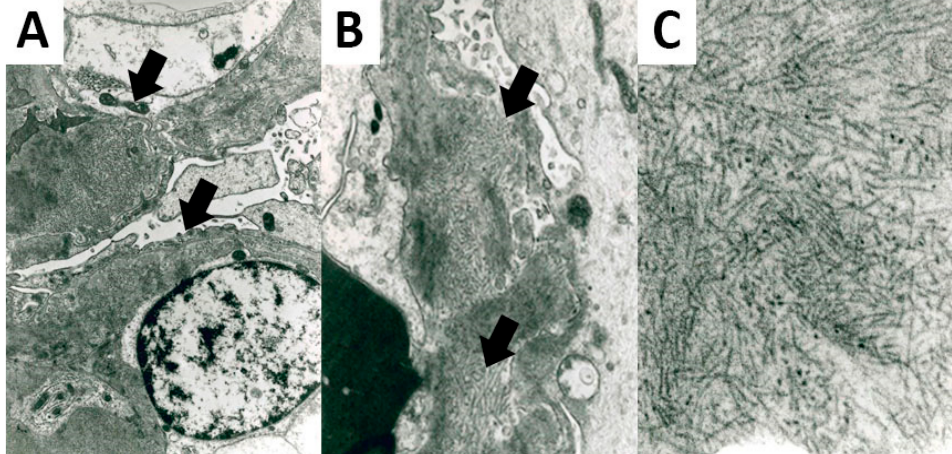
Figure 2. Ultrastructural features of FGN. Fibrils deposits were located in the glomerular basement membrane ( A ) 5200× original magnification; ( B ) 8900× original magnification, showing a straight non-branching structure and a random organization ( C ); 28,500× original magnification. Details of the LM, IF, and EM features are reported in Table 4. Table 4. Histopathology, immunofluorescence, and ultrastructural characteristics of the FGN cohort.